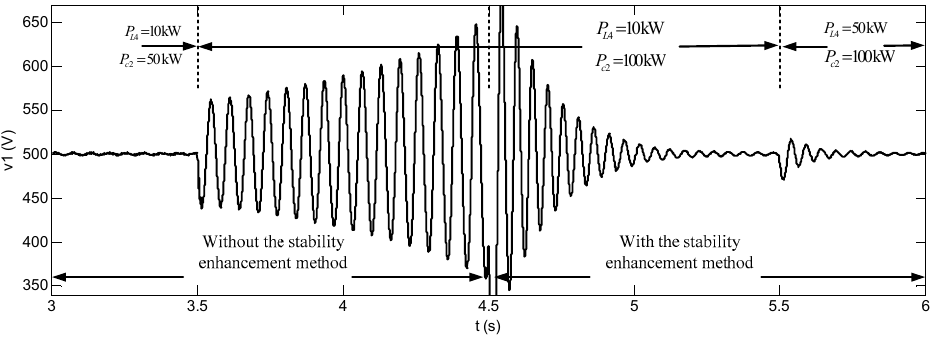
Energies 2017 , 10 , 69 14 of 16 Figure 17. The node 1 voltage v without/with the proposed stability enhancement method. Figure 17. The node 1 voltage v 1 without/with the proposed stability enhancement method. 1 The currents of cable 1 i and cable 4 i are displayed as Figure 18. The steady state and 1 cable 4 cable